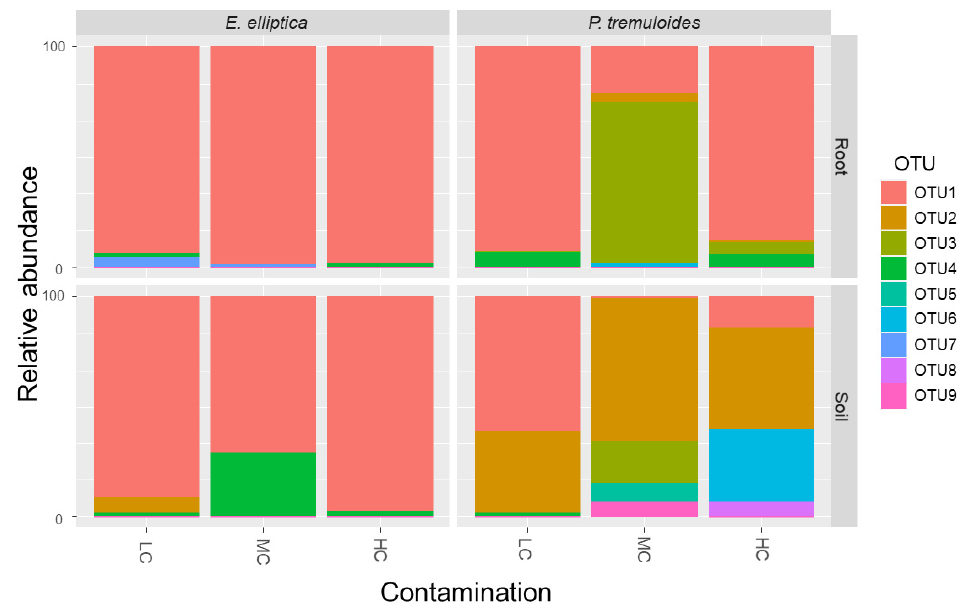
Figure 2. Relative abundance of nine Glomeromycota OTUs in the rhizosphere soil and roots of P. tremuloides and E. elliptica from decantation basins with lowest (LC), intermediate (MC) and highest (HC) petroleum hydrocarbon contamination. The identity of each OTU is summarized in Supplementary Table S2.